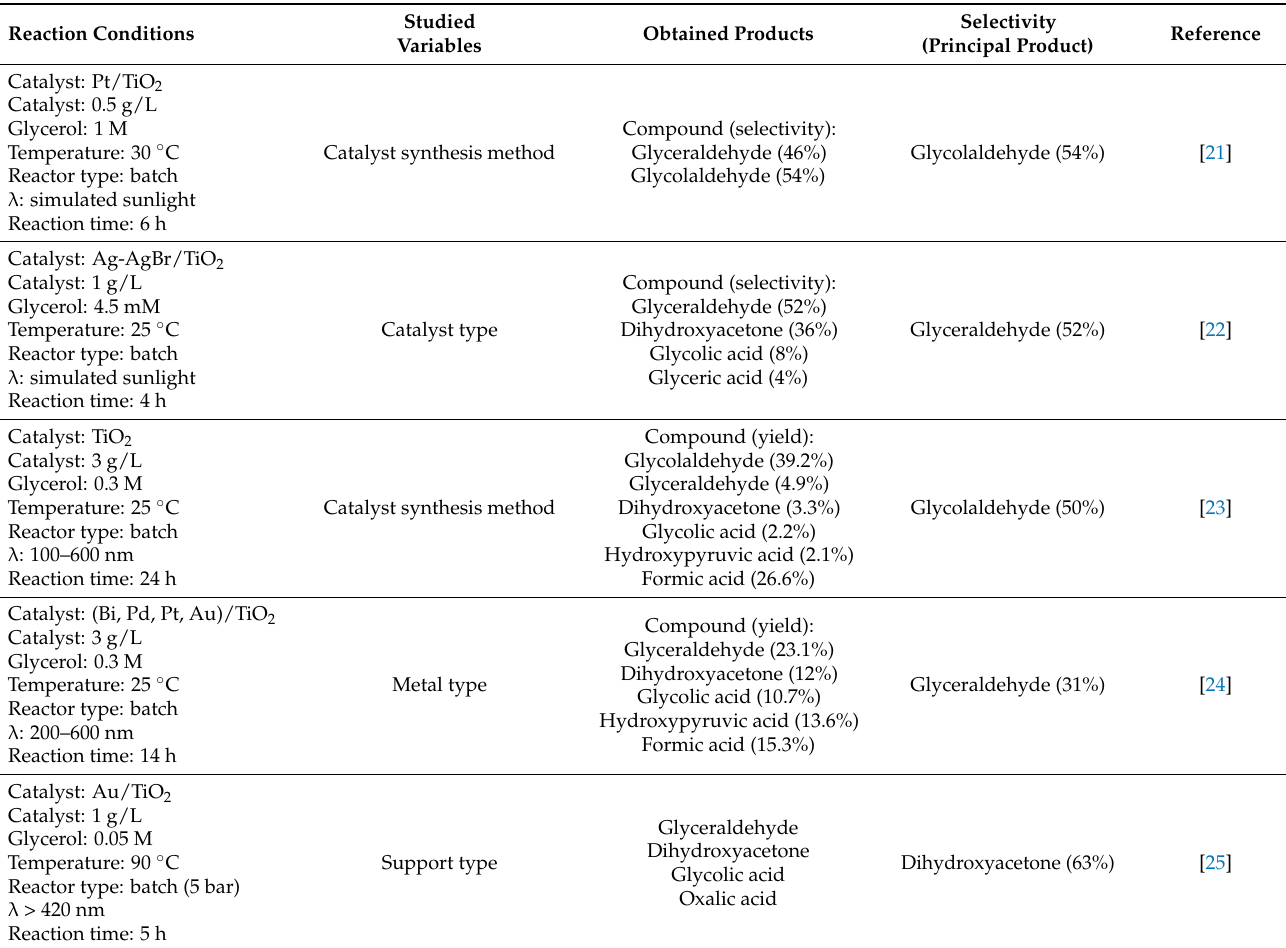
Selectivity (Principal Product)